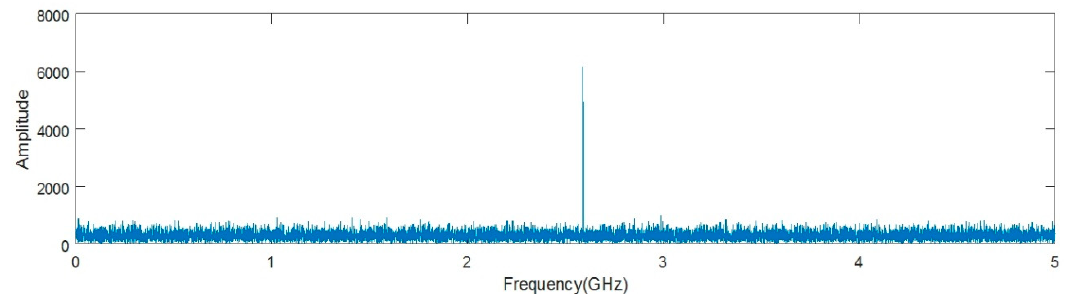
Figure 7. Original periodic function: ( a ) time domain, ( b ) frequency domain and reconstructed periodic function: ( c ) time domain, ( d ) frequency domain.